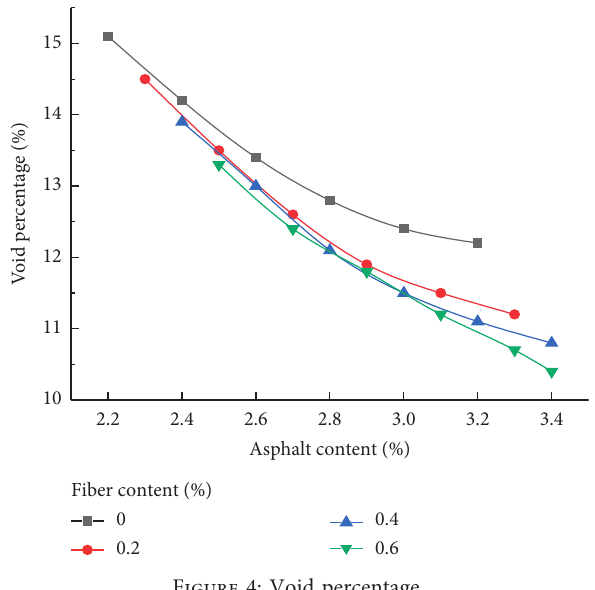
Table 7: Optimal asphalt content of microbond asphalt